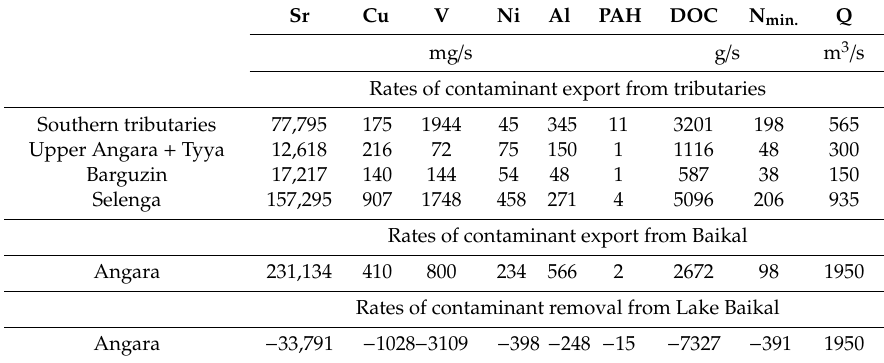
Table 6. Rates of contaminant export from Lake Baikal and tributaries; rates of contaminant removal from the lake; water discharge from the lake and